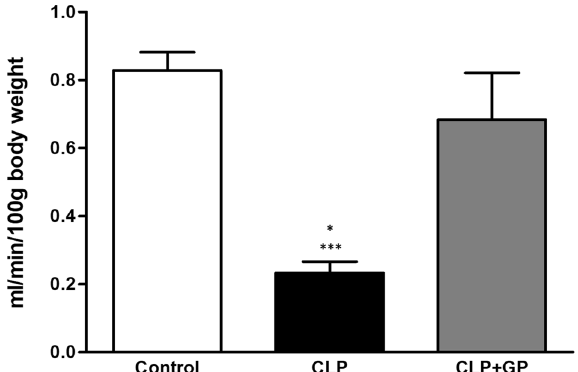
Figure 3. Renal function measured by inulin clearance (glomerular filtration rate) in control, cecal ligation and puncture (CLP), and CLP + green propolis (CLP + GP) group rats 24 h after the CLP or sham procedure. * p < 0.05 versus CLP + GP; *** p < 0.001 versus control.